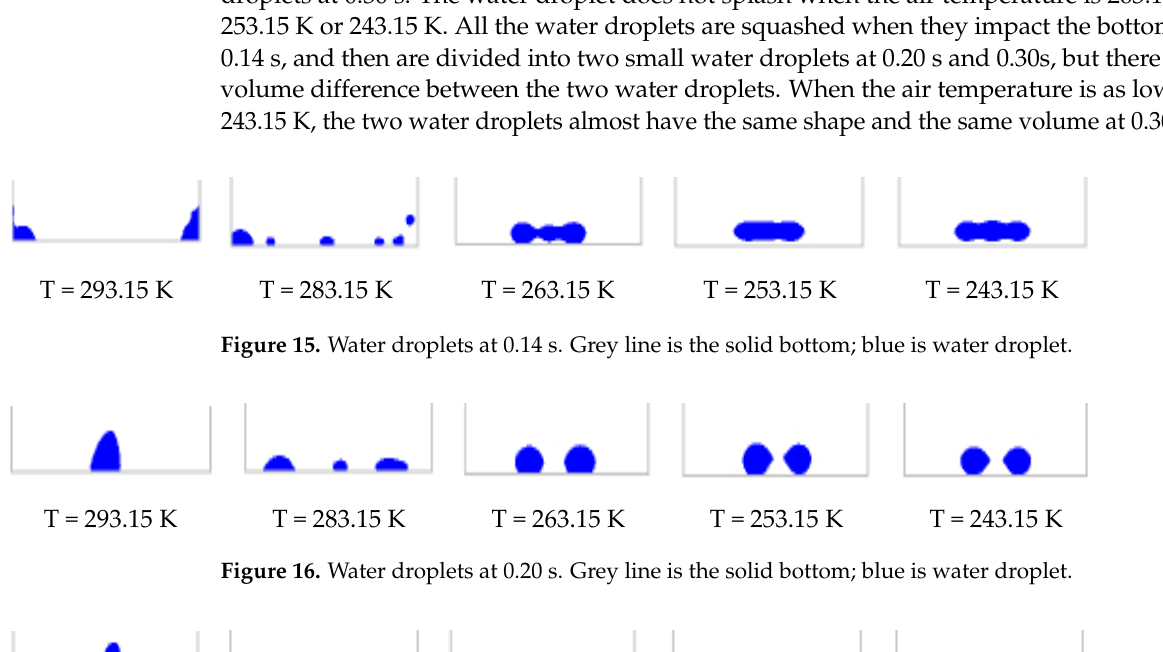
T = 293.15 K T = 283.15 K T = 263.15 K T = 253.15 K T = 243.15 K Figure 17. Water droplets at 0.30 s. Grey line is the solid bottom; blue is water droplet.